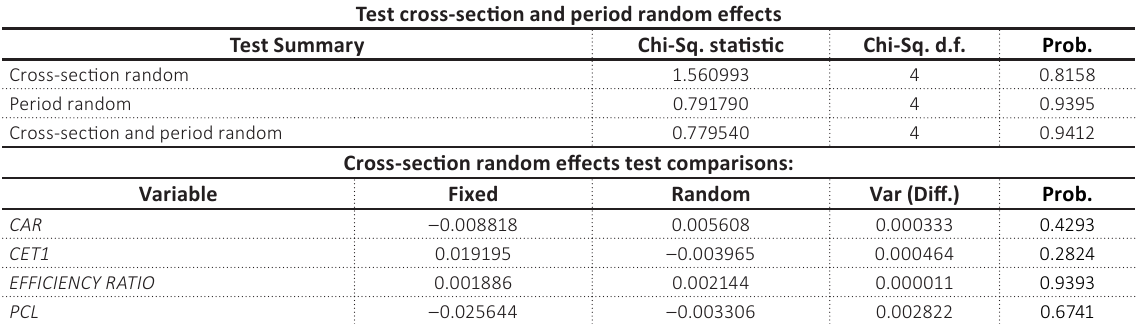
Table 4. Results of Hausman test for